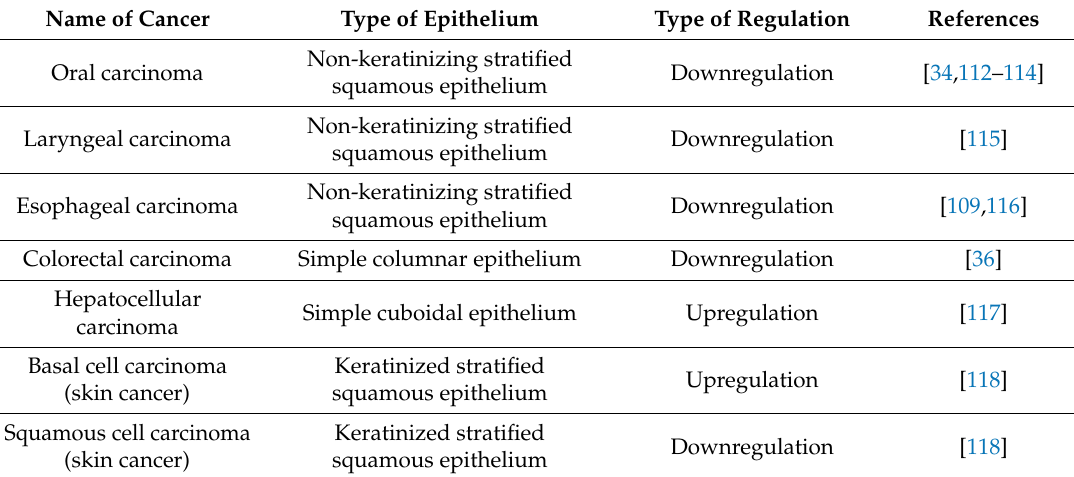
Table 3. Regulation of TGM3 in di ff erent types of epithelial